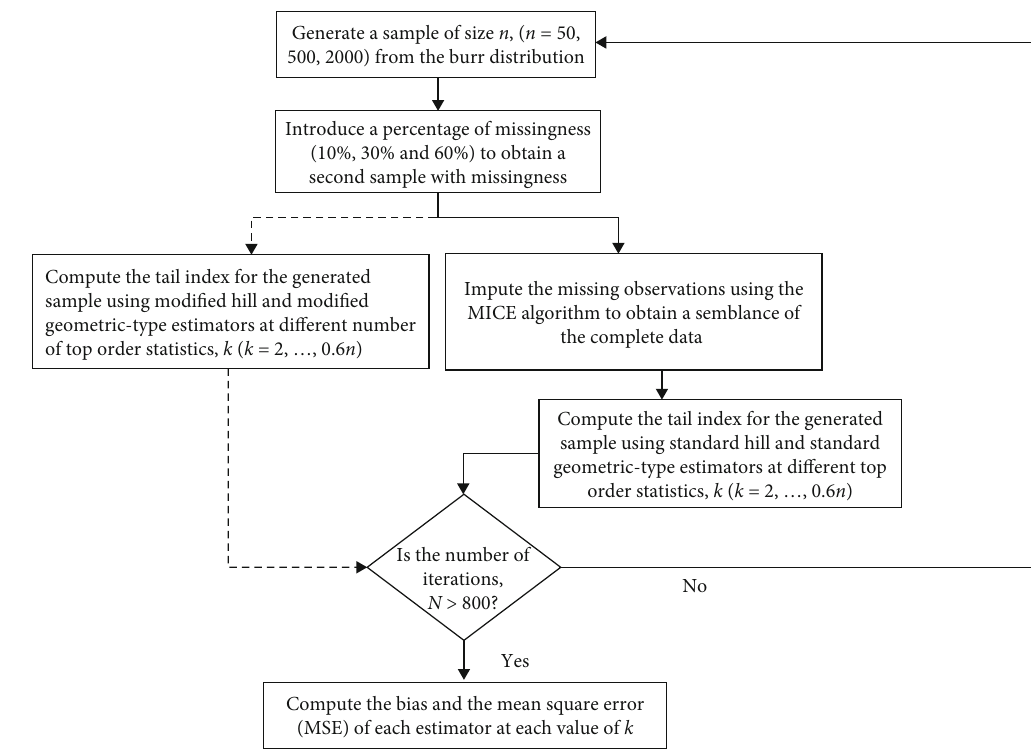
Figure 1: Simulation algorithm.